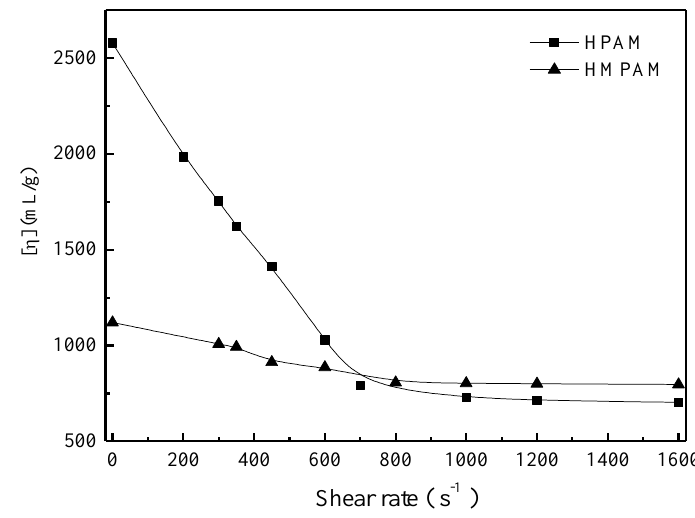
Figure 6. Intrinsic viscosity of polymers versus shear rate at 45 °C.